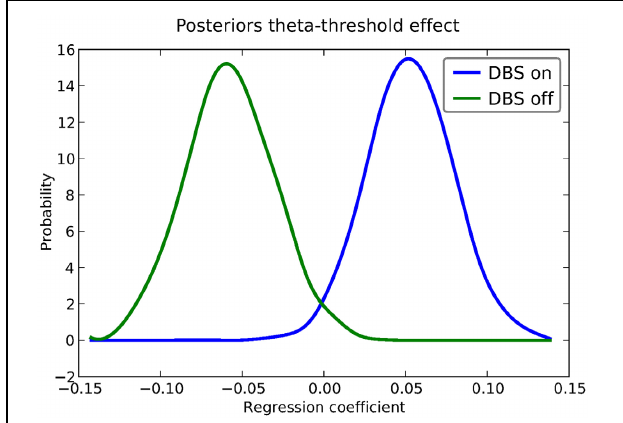
FIGURE 5 | Posterior density of the group theta regression coefficients on threshold a when DBS is turned on (blue) and off (green).